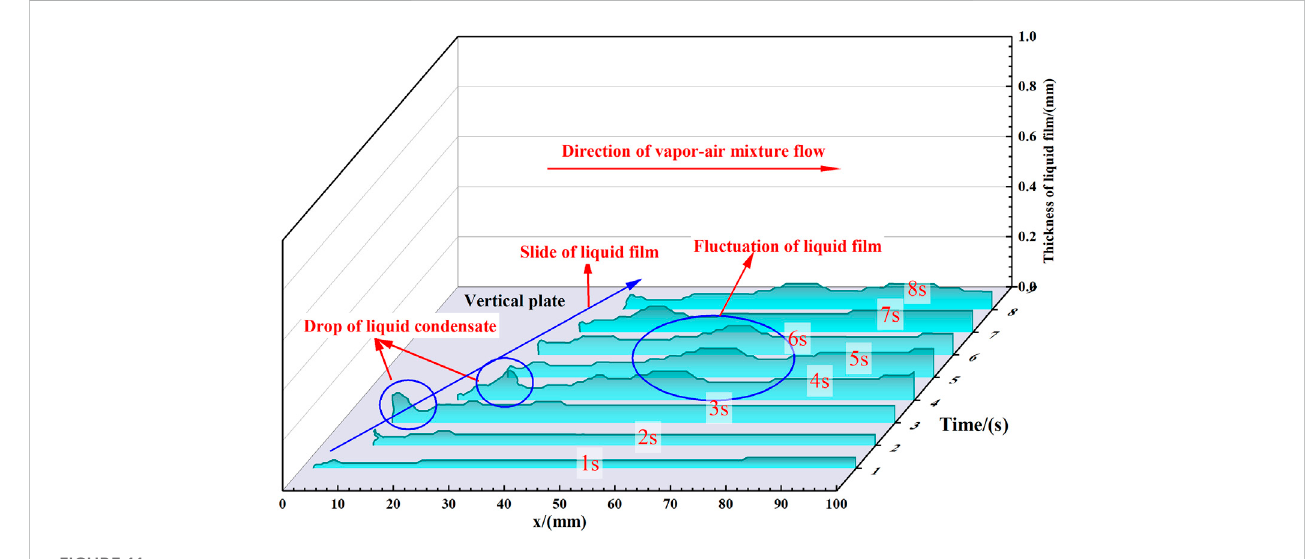
FIGURE 11 Evolution of liquid fi lm shape in Case 5.